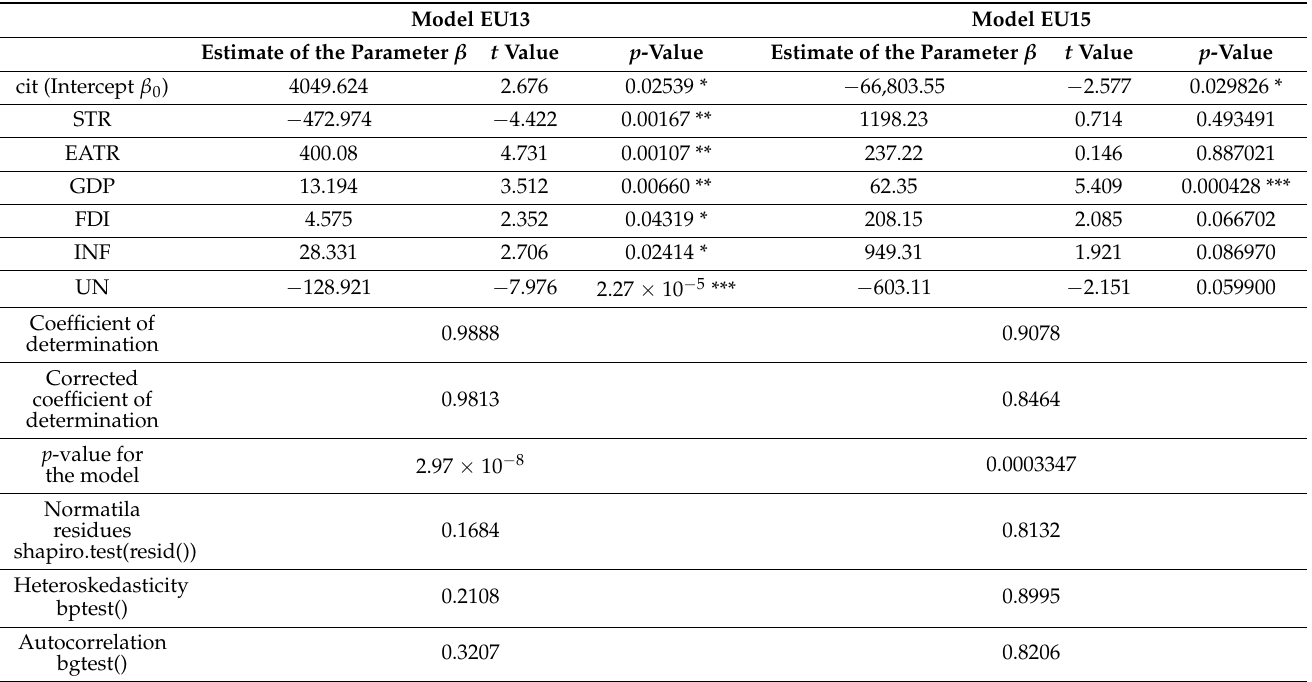
Table 2. Results of regression analysis of EU13 and EU15 models. Model EU13 Model